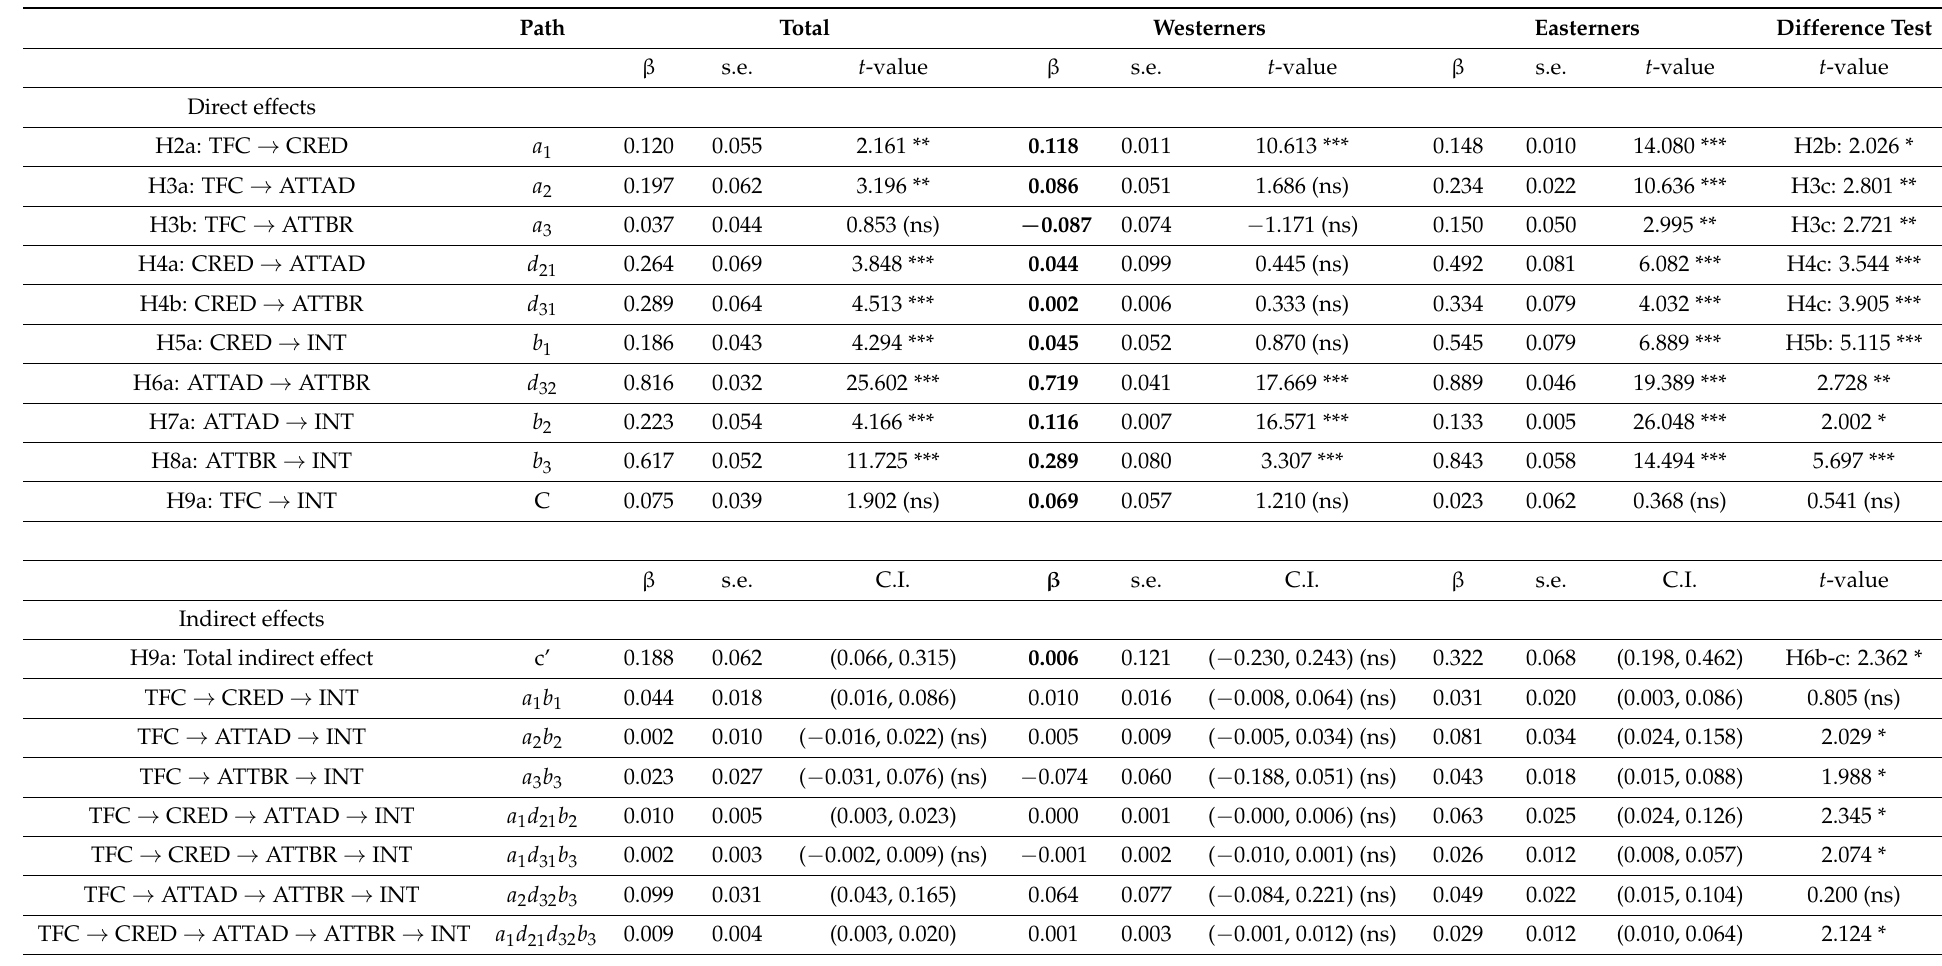
Table 6. Results of the Bootstrap Mediation Tests a